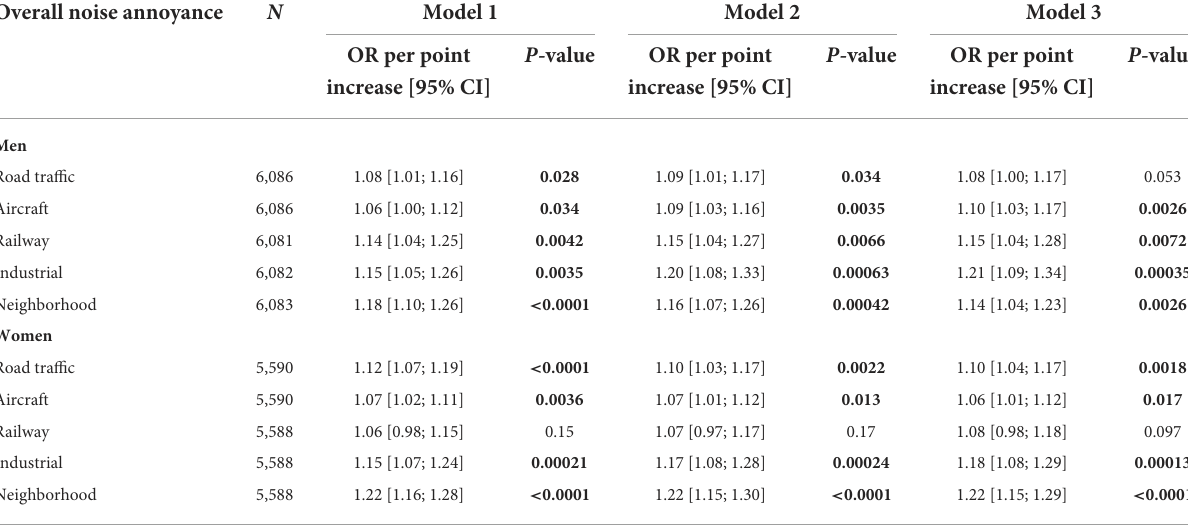
TABLE 2 Cross-sectional association analysis between source-specific overall noise annoyance and atrial fibrillation in men and women (data from the Gutenberg Health Study 2007–2012). Overall noise